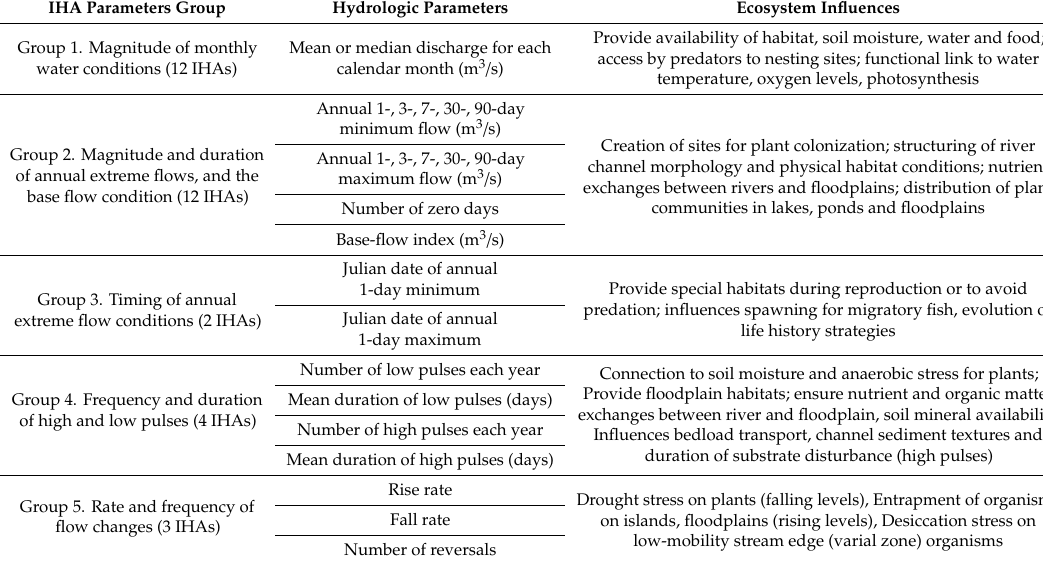
Table 1. The 33 indicators of hydrologic alteration (IHAs) adapted from IHA Manual V7